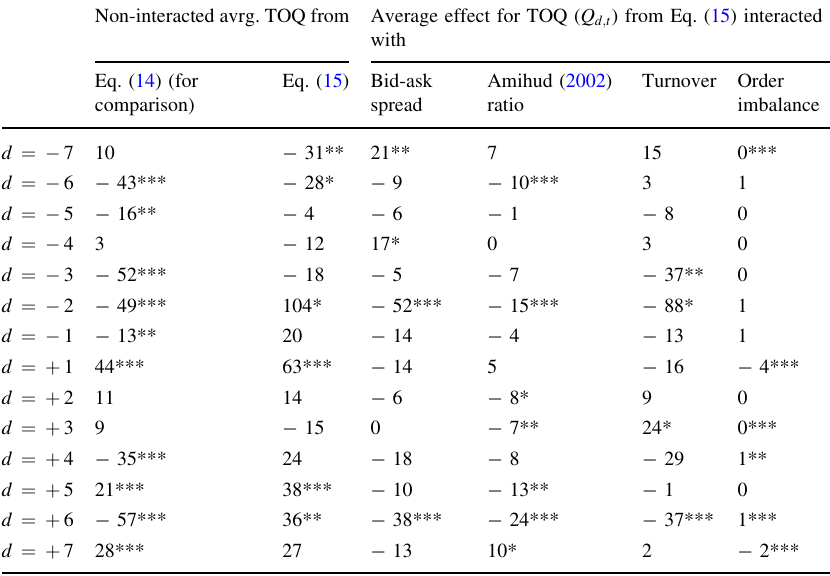
Table 5 Effects of liquidity and order imbalance on returns, part 2: turn of the quarter effect Non-interacted avrg. TOQ from Average effect for TOQ ( Q d ; t ) from Eq. (15) interacted with Eq. (14) (for